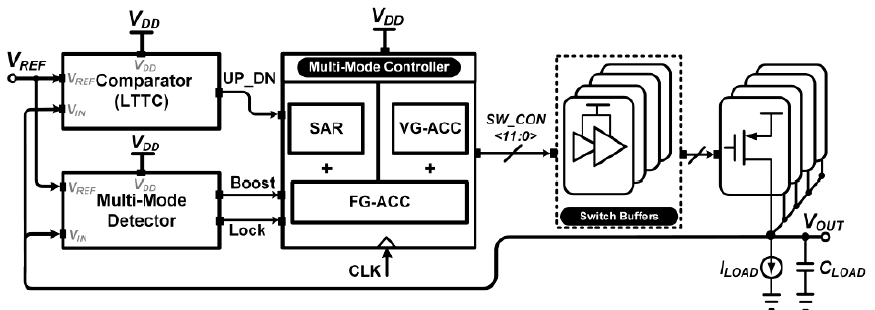
Figure 26. Fully Standard Cell-Based DLDO [52].